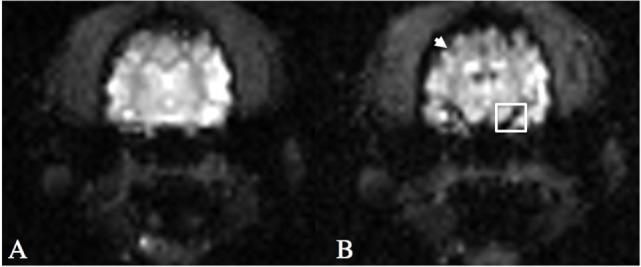
T2*W echo-planar imaging sequence following gadolinium-based contrast injection at T = 0 (A) and time of peak arterial contrast susceptibility (B) at the level of the middle cerebral artery. Note the hypointense cortical arteries around the periphery of the cerebrum (arrow) and the middle cerebral artery (box) at peak contrast susceptibility.